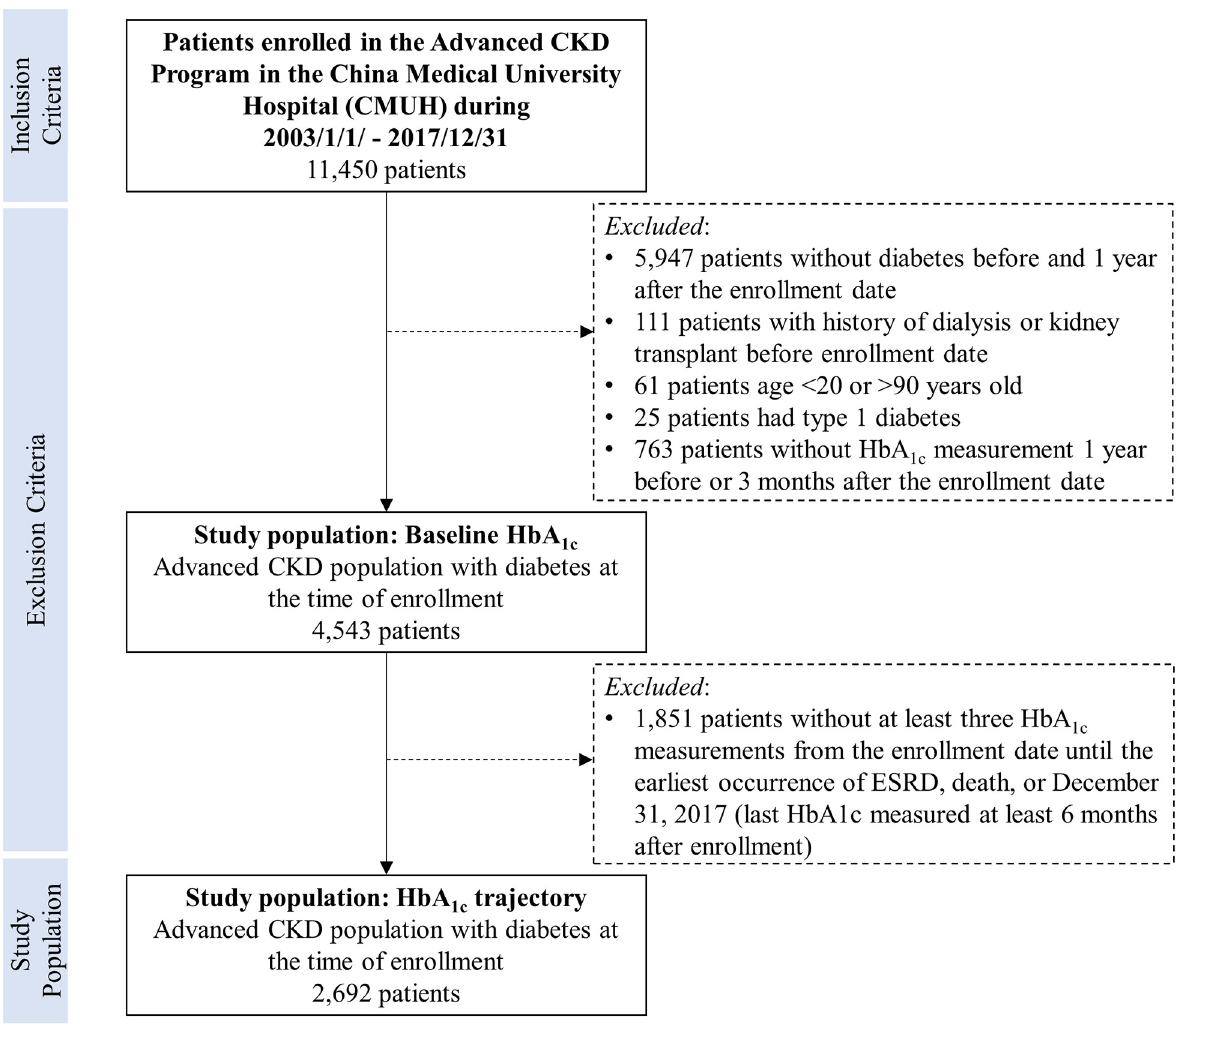
Fig 1. Selection of the study